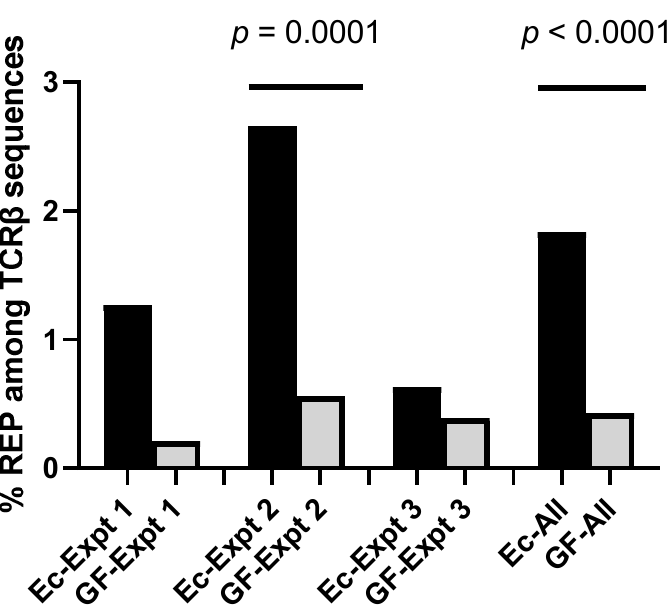
Figure 1. Percentages of REP sequences among all unique TCR β sequences in Ec and GF mice. Percentages are shown for the numbers of REP sequences in Ec and GF mice in three independent experiments examined individually and together (All). There were 2 Ec and 2 GF mice in experi- ment 1, 4 Ec and 4 GF mice in experiment 2, and 2 Ec and 4 GF mice in experiment 3. In each ex- periment, REP frequencies were higher in Ec mice compared to GF mice. REP frequencies were significantly different between mouse groups in experiment 2 (the largest experiment), and in se- quences from combined experiments. Fishers Exact tests were used.